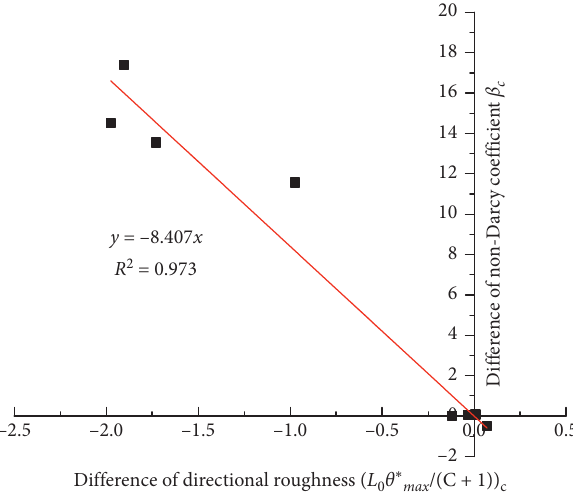
Figure 12: Relationship between the difference of non-Darcy coefficient β C and the difference of directional roughness ( L θ ∗ / ( C + 1 )) C 0 max